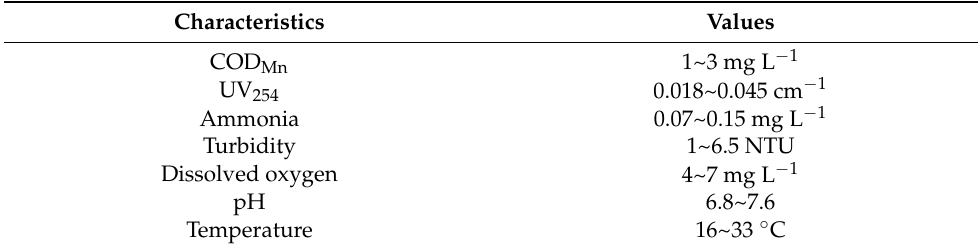
Table 1. Characteristics of raw water quality during the experiment. Characteristics